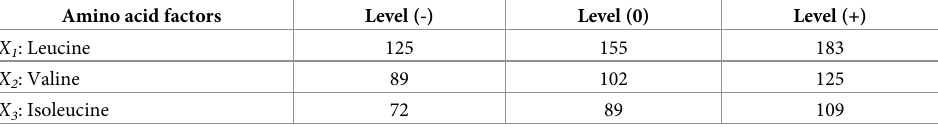
Table 1. Relativity of three tiers of digestible branched-chain amino acid concentrations to lysine (100) in experi- mental diets 1 containing 11.0 g/kg digestible lysine and 175 g/kg crude protein applied to a 3-factor, 3-level Box- Behnken